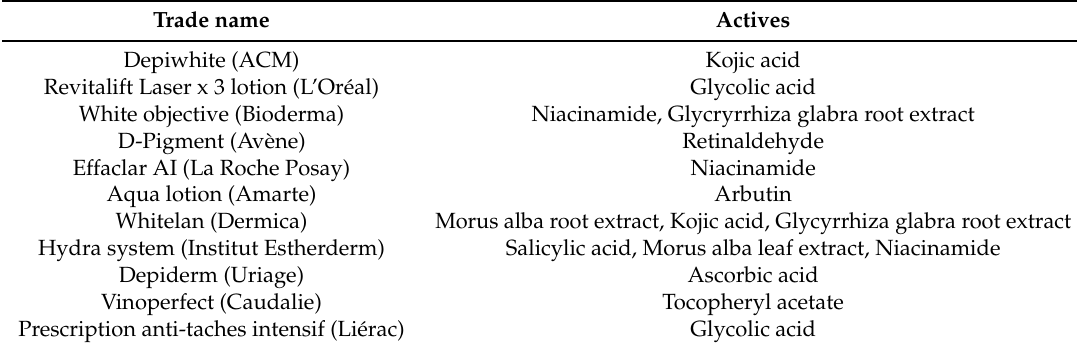
Table 3. Some commercial lighting